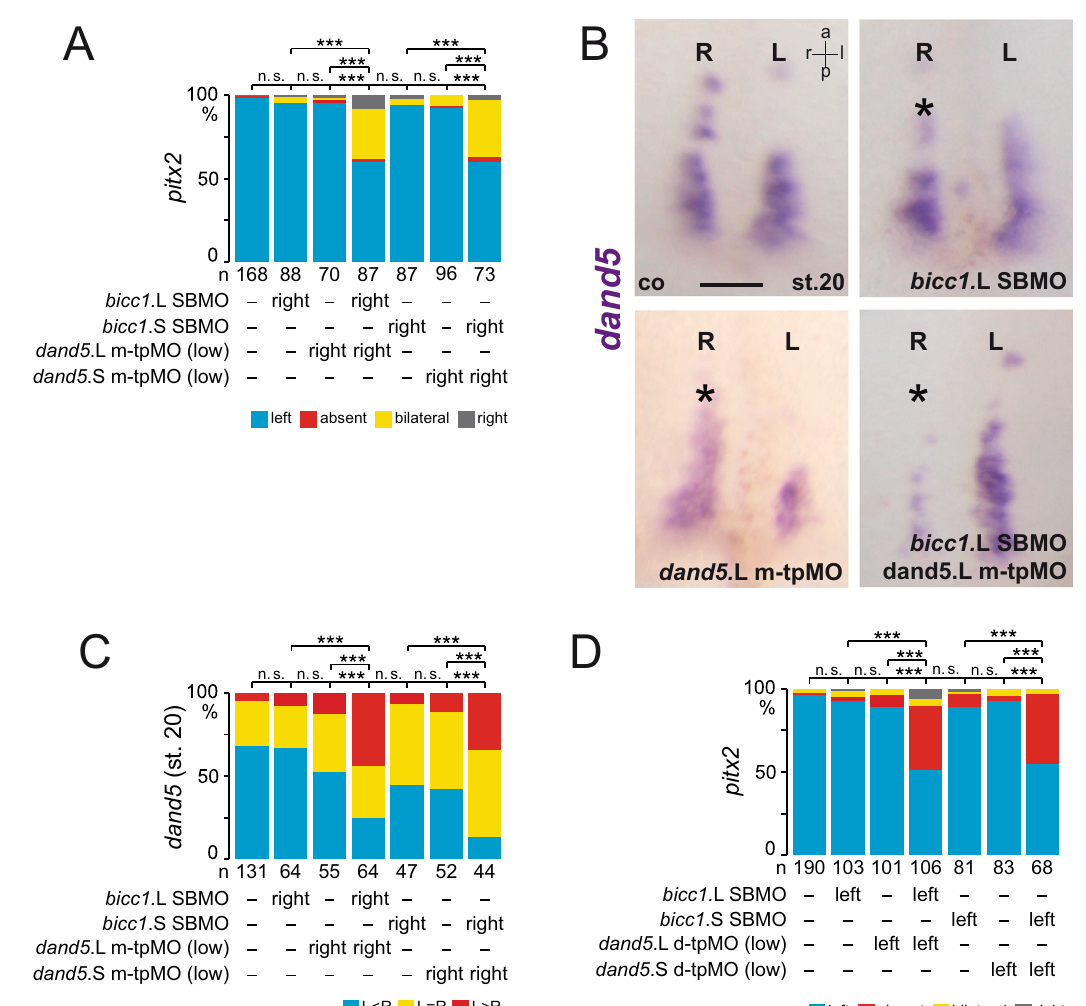
Fig. 5 Bicc1 regulates dand5 mRNA through distinct regions of the Bicc1RE. A Quanti fi cation of right-sided pitx2 induction by co-injecting a low, ineffective m-tpMO dosage with single allele-speci fi c bicc1 SBMO. Controls (co), m-tpMO (S or L, low), or allele (S or L) speci fi c bicc1 SBMO alone showed wt pitx2 asymmetry. B Co-injecting m-tpMO (low) with bicc1 TPMO (L or S) impacted dand5 mRNA stability. Treatment with low concentrations of m-tpMO, single allele-speci fi c bicc1 TPMO, and uninjected co showed wt dand5 expression at post- fl ow stages. C Quanti fi cation of dand5 expression. D Quanti fi cation of pitx2 asymmetry. Only in combination both suboptimal dosages of d-tpMO (low) or single allele-speci fi c bicc1 SBMO (S or L) prevented left pitx2 expression. Wt expression was found in controls (co) and in embryos that were left-sided injected with one MO alone. MO pmol/embryo: bicc1 SBMO (L or S, 1); m-tpMO low (L or S, 0.4); d-tpMO low (L or S, 0.5). Asterisks in B mark injected side. Numbers (n) in A , C , and D represent analyzed specimens from more than independent experiments. Statistical analyses were done with one-sided Pearson ’ s chi-square test, which was adjusted